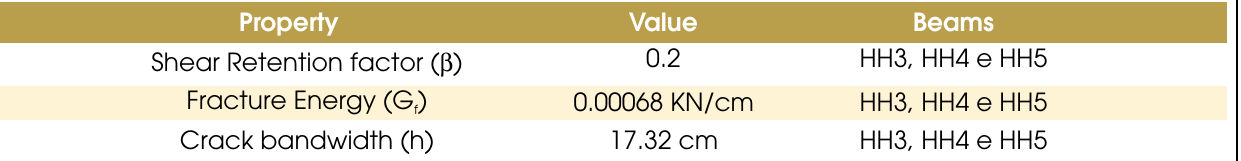
Table 3 – Parameters for the Hordijk model